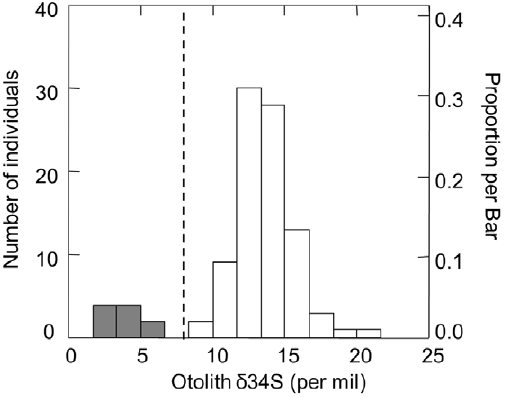
Figure 3. Frequency distribution of d 34 S values in salmon otoliths. Histogram of otolith d 34 S for the juvenile rearing portion of otoliths from unknown origin adult Chinook salmon ( Oncorhynchus tshawytscha ) spawning in-river on the Mokelumne River (USA). Fish assigned to natural origin (grey bars; N=87) had d 34 S values less than 6 % (dashed line) and did not overlap with d 34 S values from those identified as originating from a hatchery (open bars; N=10). These results indicate that 90% of in-river spawners were produced in a hatchery.